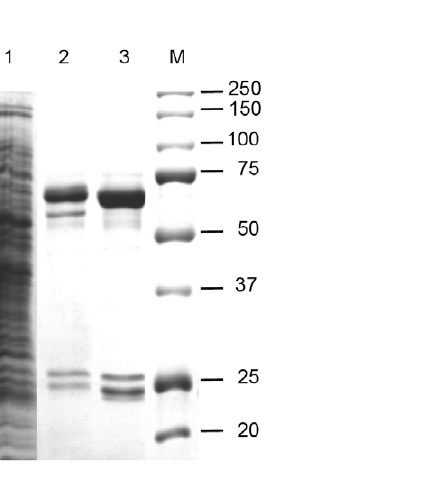
Figure 2. Purification of the HoxFU module of the R.eutropha SH. Soluble extract (20 m g, lane 1) and purified protein after Strep - Tactin affinity chromatography (3 m g, lane 2) and subsequent size exclusion chromatography (3 m g, lane 3) were separated by SDS-PAGE and stained with Coomassie blue. A standard protein ladder and the corresponding sizes in kDa are shown in lane M. Arrows indicate the HoxF protein at 67 kDa and two subforms of HoxU at approximately 27 and 23 kDa.